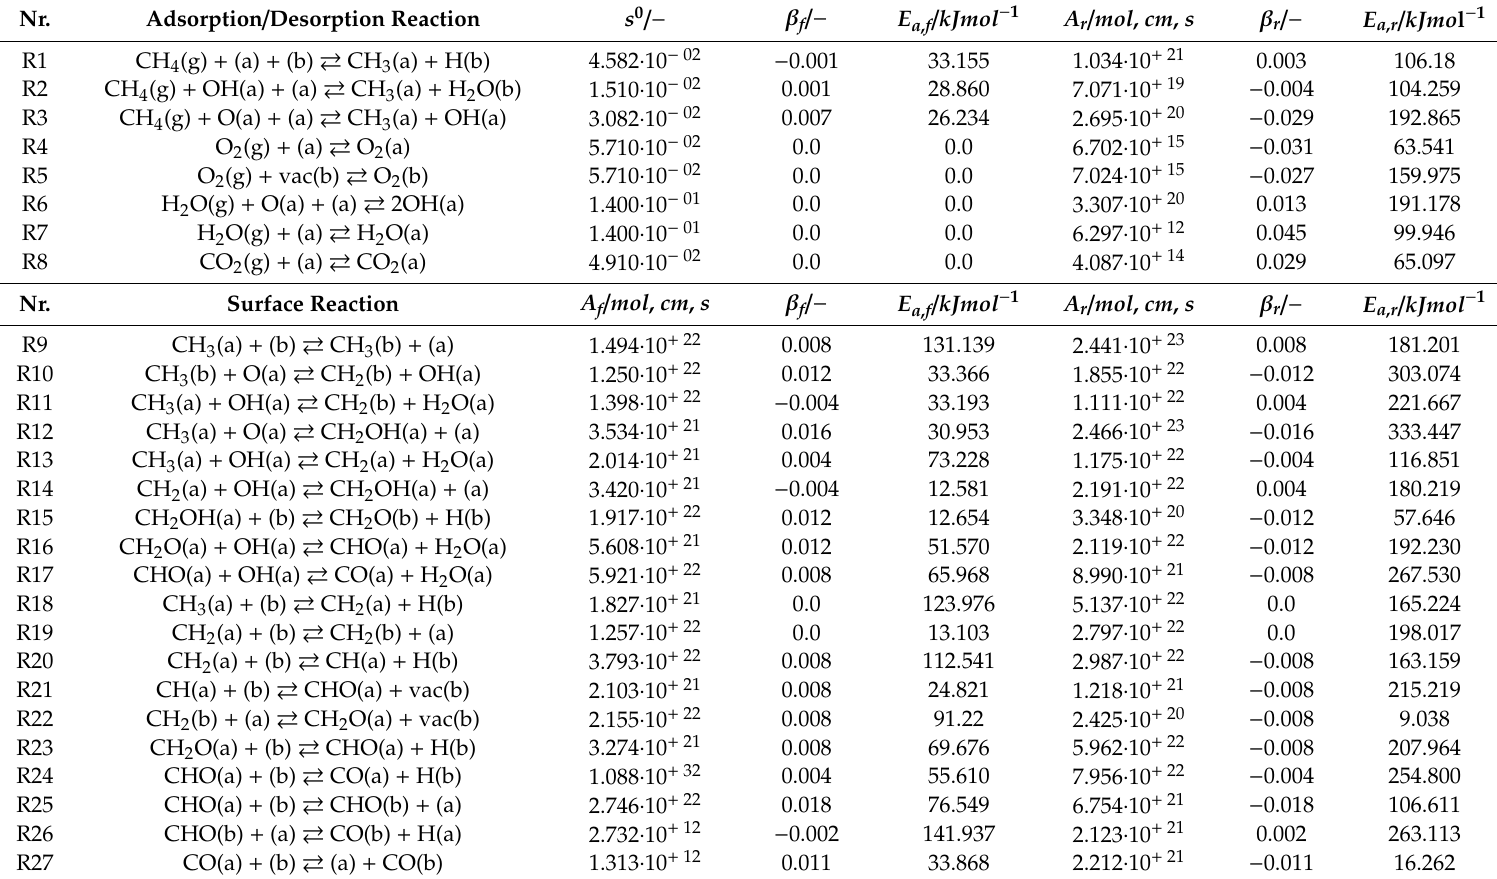
Table A1. Kinetic parameters of the two-site mean field reaction mechanism for methane oxidation over PdO in the form of the modified Arrhenius expression. The mechanism is fully thermodynamically consistent. The coordinatively unsaturated Pd sites are denoted as (a), whereas the lattice oxygen sites of PdO (1 0 1) are represented by (b)